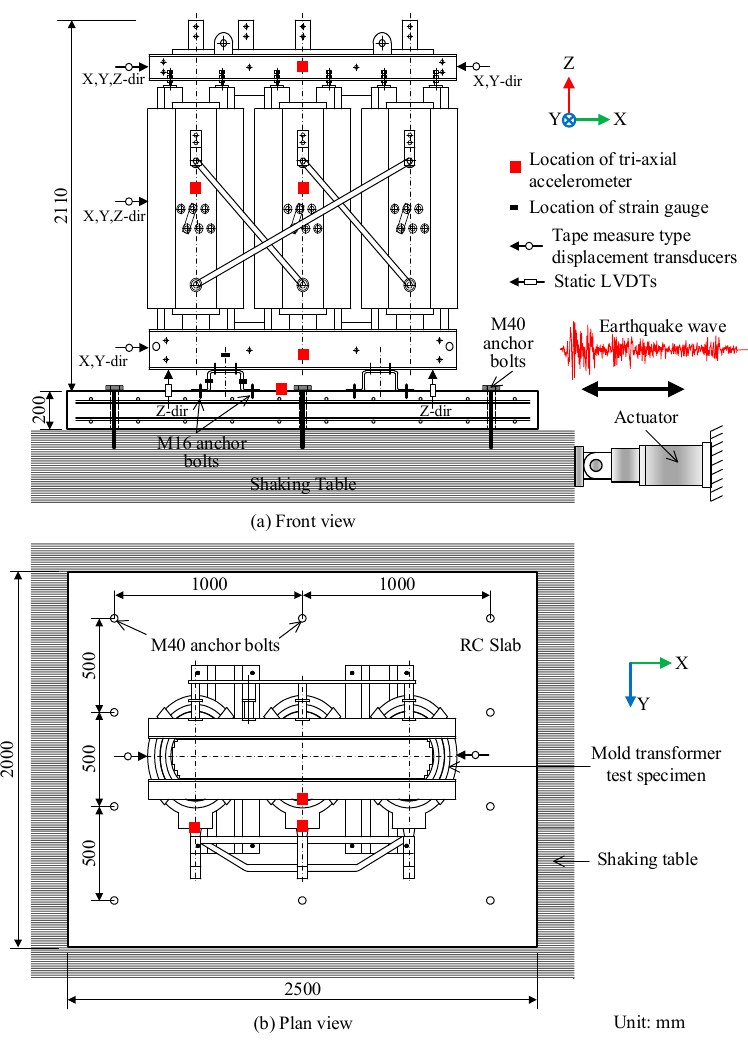
Figure 1. Configurations and details of test specimen. HV, high-voltage; LV, low-voltage: ( a ) Three-dimentional view; ( b ) Side view; ( c ) Plan view; ( d ) Photo of hybrid mold transformer.